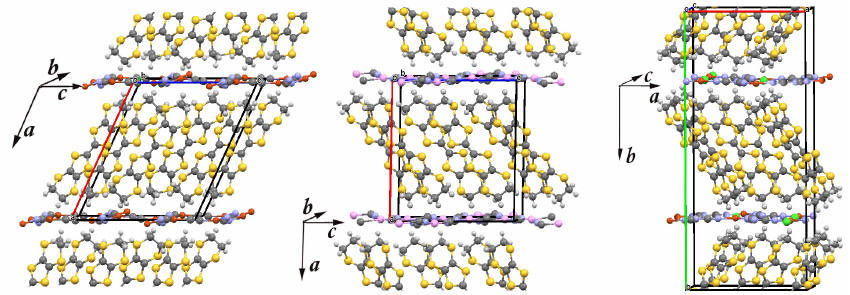
Figure 1. The crystal structure of three layered organic charge-transfer salts κ -(BEDT-TTF) 2 X ( X = Cu 2 (CN) 3 , Ag 2 (CN) 3 , and Cu[N(CN) 2 ]Cl). Carbon, sulfur, and hydrogen atoms of the bis(ethylenedithio)tetrathiafulvalene [CH 2 ) 2 ] 2 C 6 S 8 (BEDT-TTF) molecule are denoted in dark gray, yellow, and light gray, respectively. In the anion (X) network, chlorine, cooper, silver, carbon, and nitrogen are denoted in green, red, pink, dark grey, and violet, respectively. The lines mark the unit cell. Left panel : The unit cell of κ -CuCN contains 4 BEDT-TTF molecules and 2 Cu 2 (CN) 3 anions. Middle panel : The unit cell of κ -AgCN contains 4 BEDT-TTF molecules and 2 Ag 2 (CN) 3 anions. Right panel : The unit cell of κ -Cl contains 8 BEDT-TTF molecules and 4 Cu[N(CN) 2 ]Cl